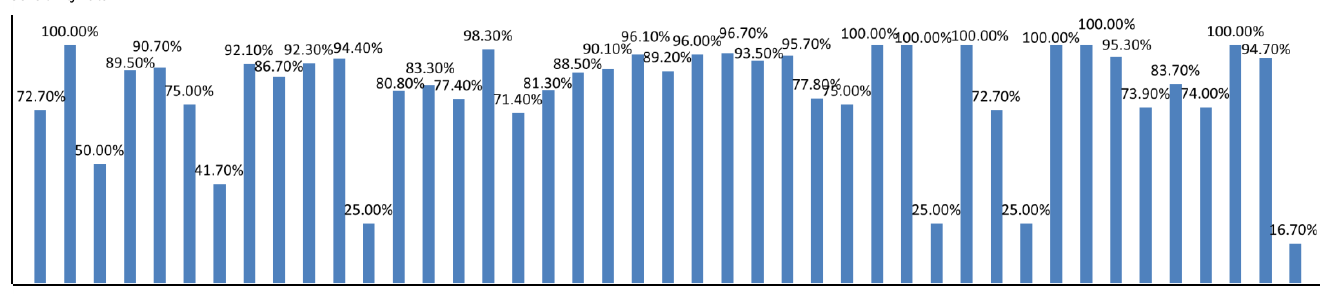
Fig. 10. The results of